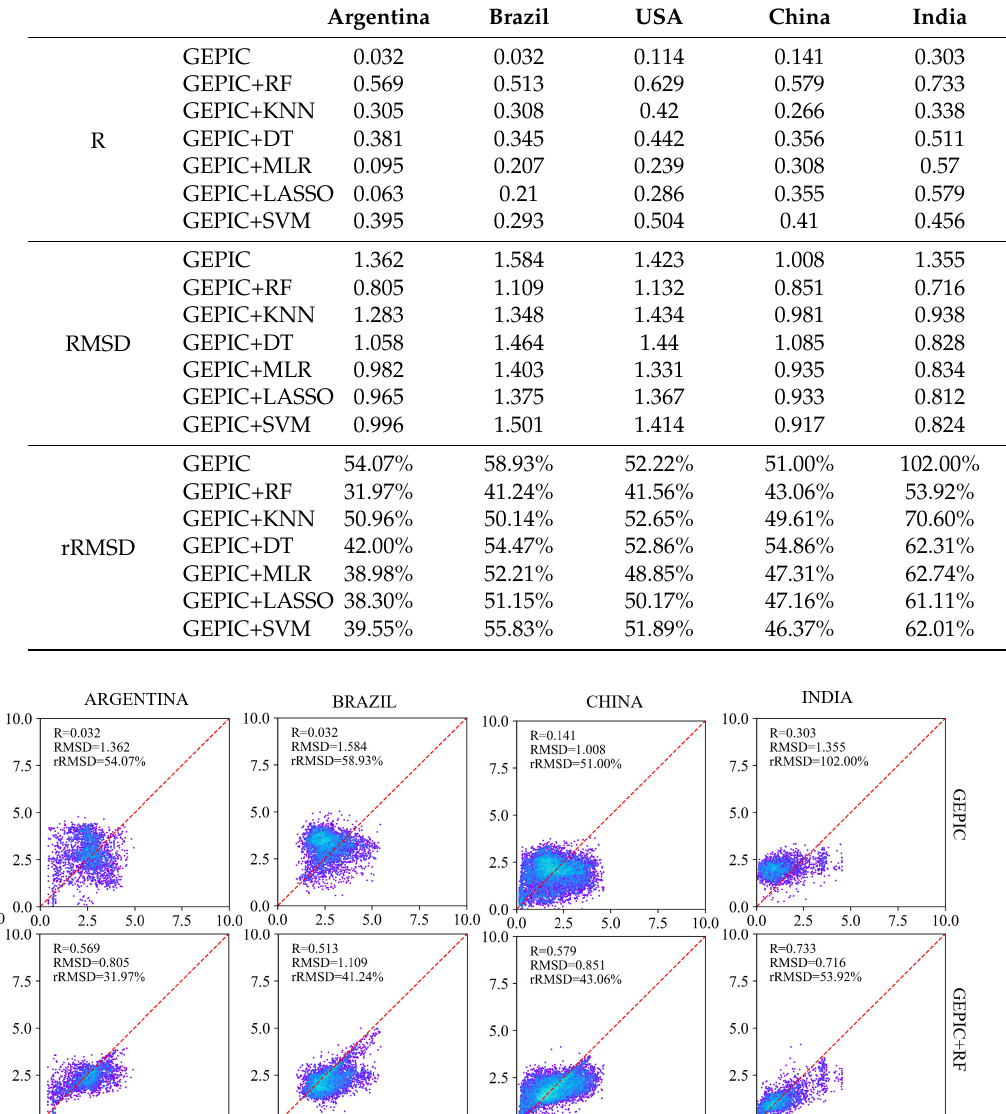
Table 2. Evaluation metrics of GEPIC and GEPIC+ML models for globe and main producing countries during the historic period.